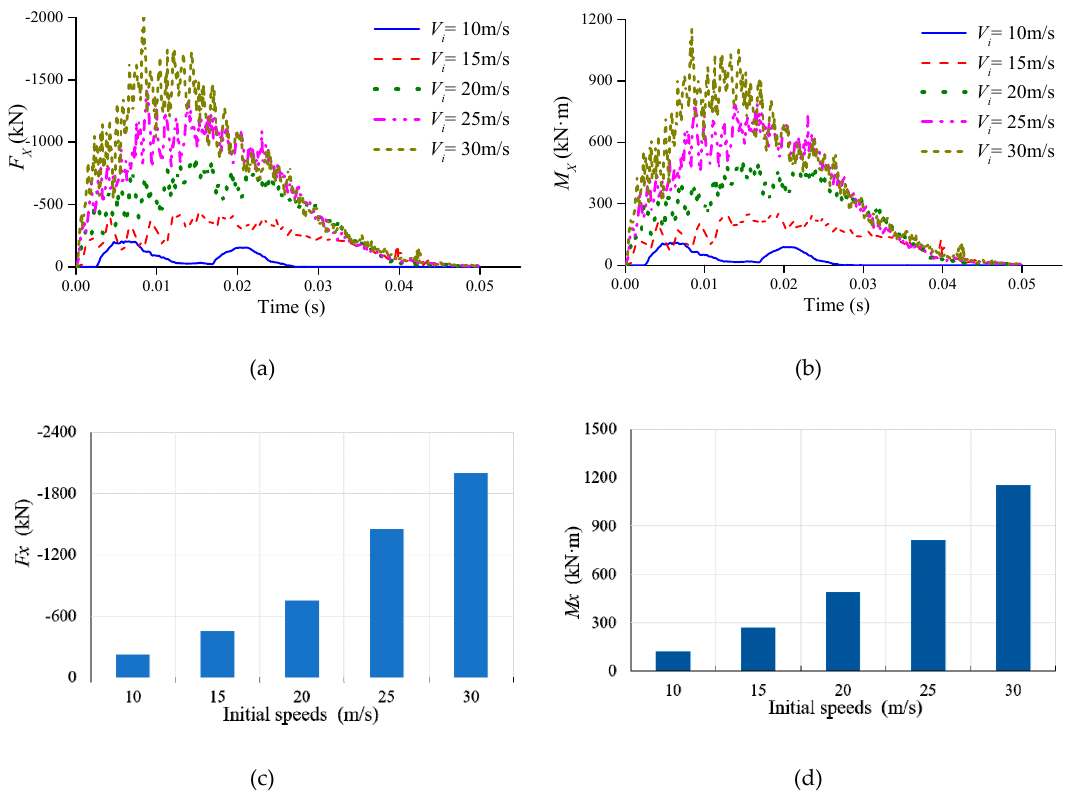
Figure 21. Time series of ice load Fx and Mx based on simulations with different ice initial speeds. ( a ) The Fx with different initial speeds. ( b ) The Mx with different speeds. ( c )The maximum Fx with different initial speeds. ( d ) The maximum Mx with different initial speeds.